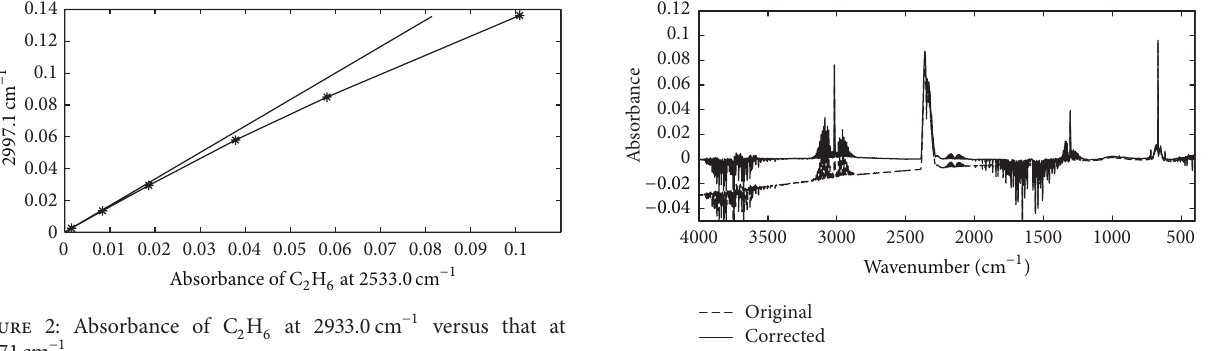
Figure 3: Spectra of methane before and after baseline correction has been